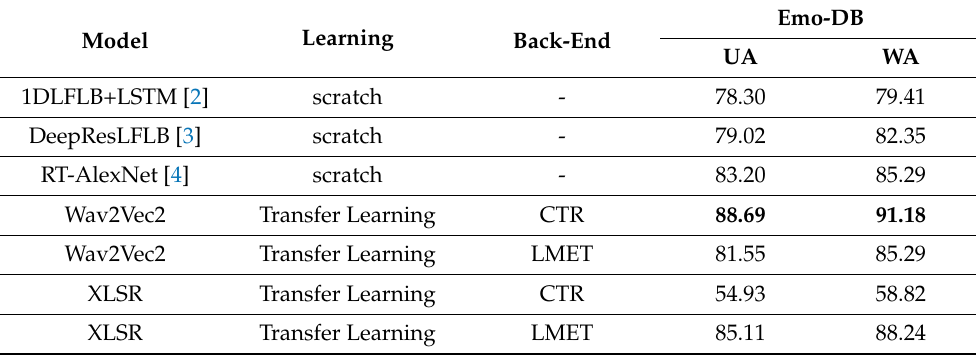
Table 4. Comparison of our proposed framework and baseline average UA and WA metrics on the Emo-DB dataset. The numbers in bold indicate the row with the best